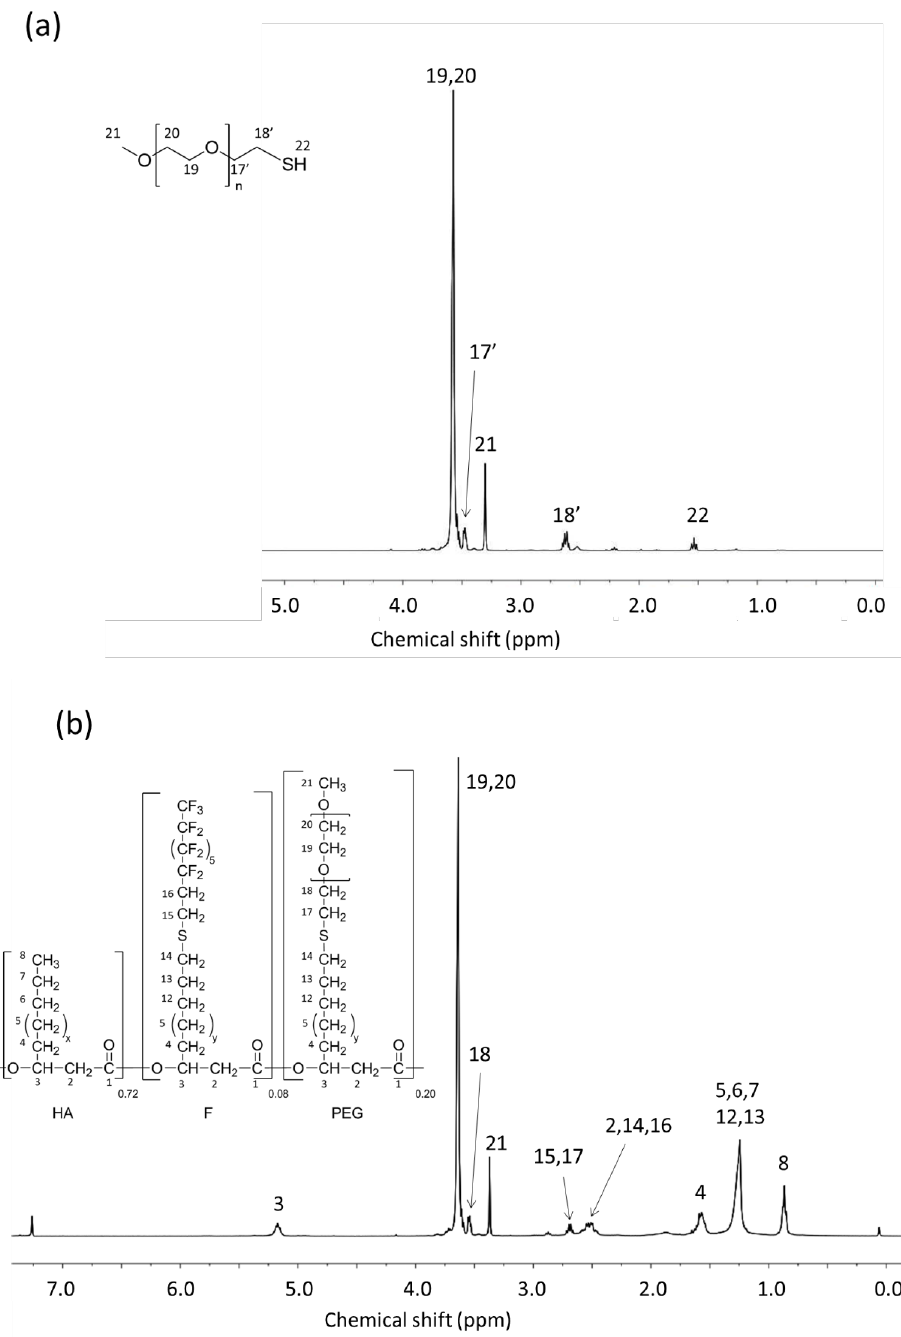
Figure 6. 1 H NMR spectra in CDCl 3 . ( a ) PEG 550 -SH; ( b ) PHA-g-(C 8 F 17 ; PEG).